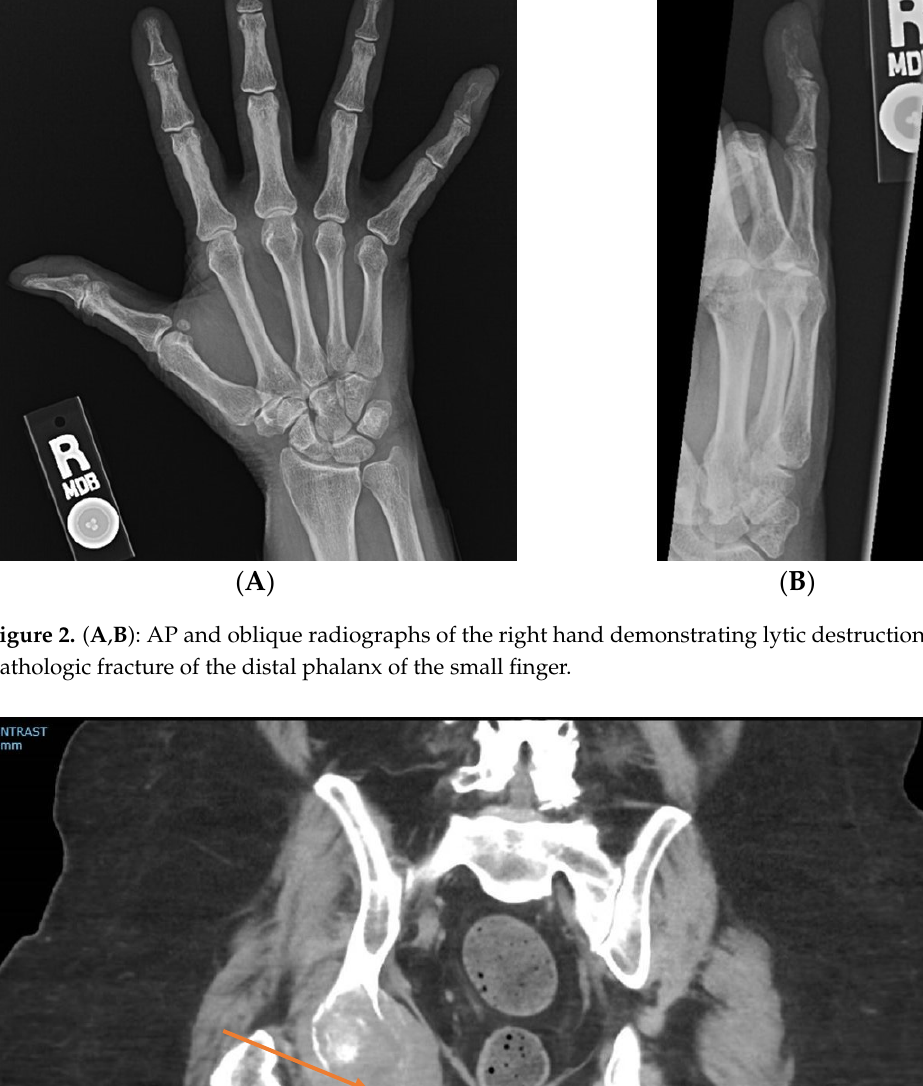
Figure 2. ( A , B ): AP and oblique radiographs of the right hand demonstrating lytic destruction and pathologic fracture of the distal phalanx of the small finger.